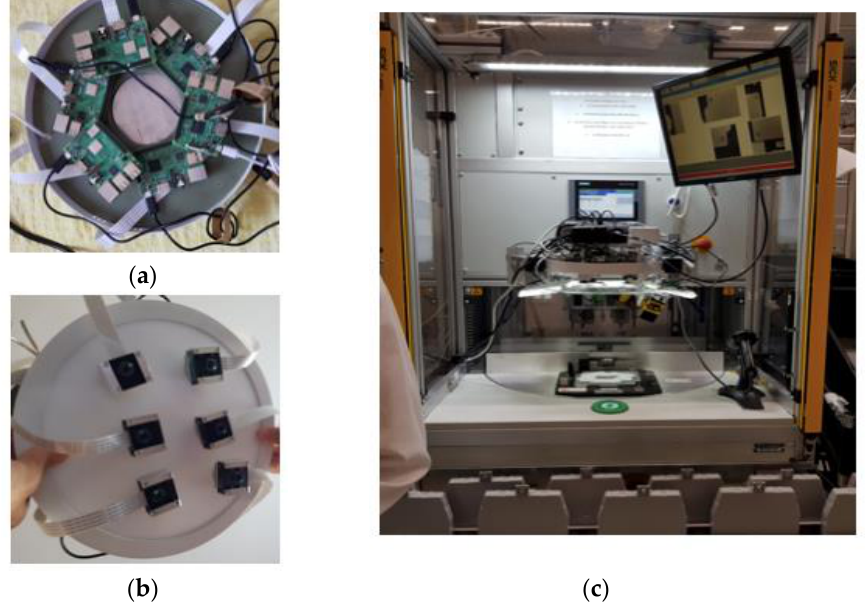
Figure 18. First phase of the IP-LC-FD prototype ( a ) upper side view over the installed Raspberry Pis, ( b ) lower side view over the cameras that are magnetically attached to the illuminating surface, ( c ) the prototype installed on the operational machine.